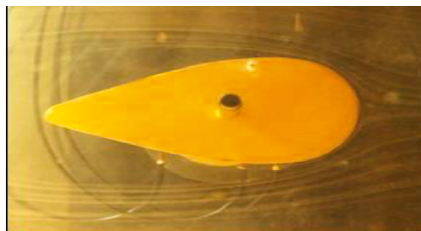
d and angle of attack.